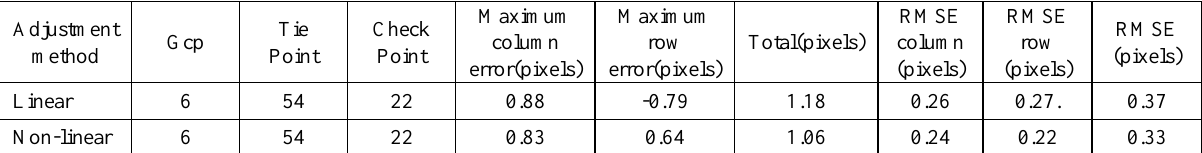
Table 1. Precision statistics of linear and non-linear adjustment